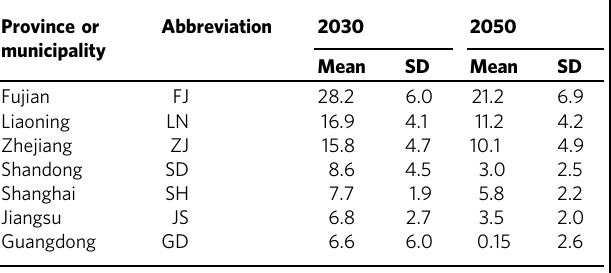
Fig. 2 Geographic distribution of levelized cost of hydrogen (LCOH) estimated for offshore China. a and b are for 2030 and 2050, respectively. Results from the baseline scenario assuming the methylcyclohexane (MCH) transport mechanism are presented. The dashed black lines denote offshore wind areas which are in closest proximity to particular provincial-level administrative divisions. LN, TJ, HB, SD, JS, SH, ZJ, FJ, GD, GX, and HN are the abbreviations for Liaoning, Tianjin, Hebei, Shandong, Jiangsu, Shanghai, Zhejiang, Fujian, Guangdong, Guangxi, and Hainan, respectively. Table 1 Cost-competitive hydrogen potential from coastal provinces or municipalities in